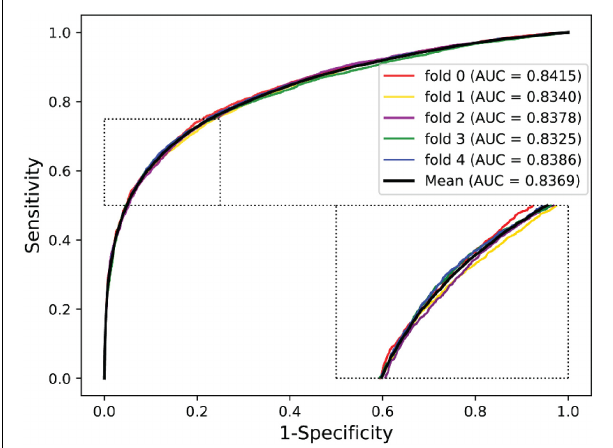
FIGURE 2 | The ROC curves of our approach on the A. thaliana dataset under five-fold CV.